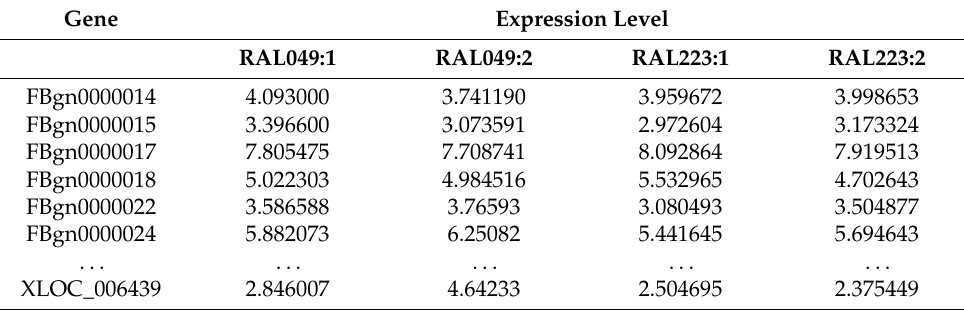
Table 2. Expression-level matrix data structure (sample).